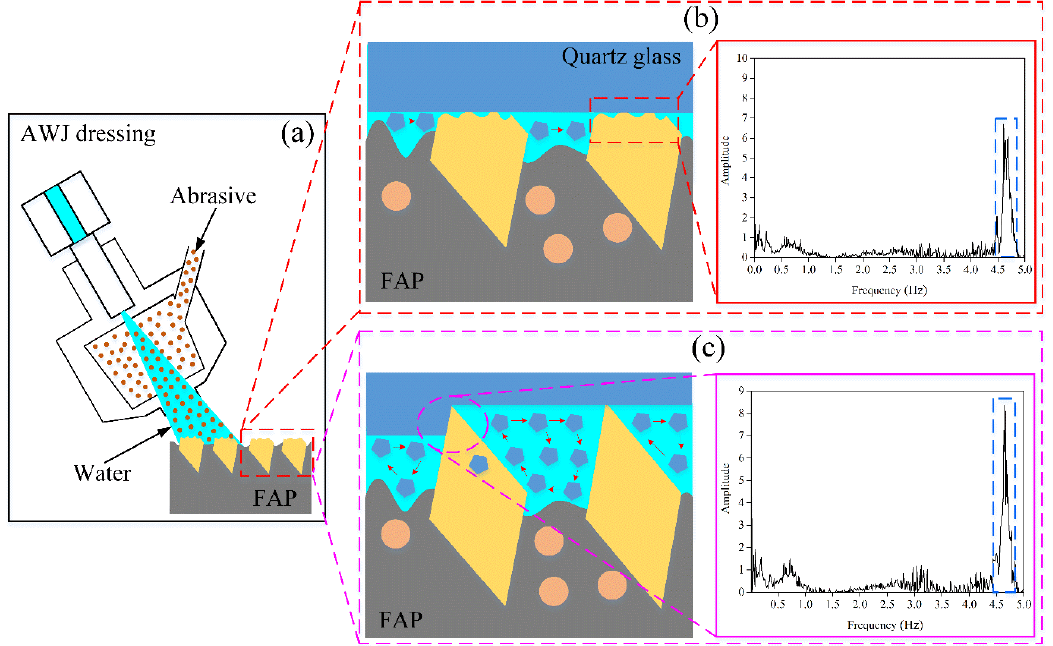
Figure 16. Lapping mechanism of FAP: ( a ) schematic diagram of AWJ dressing; ( b ) 2 MPa; ( c ) 4